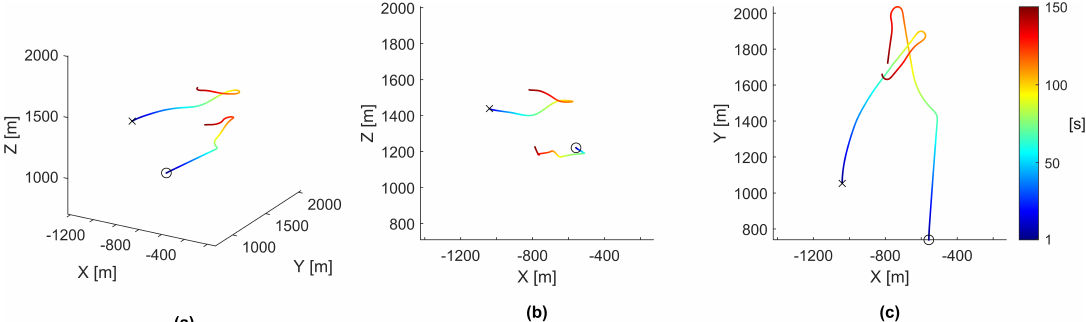
Figure 5. Paths of agents 19 and 30 as they work together to find and exploit a thermal updraft. Agent 19 is marked with an ‘x’ and agent 30 is marked with an ‘o’. Each individual agent’s path was colored by time from start to finish measured in seconds, as shown by the color-bar on the right side. The rendered path data only covers the first 150 s of the simulation. All panels show different perspectives of the same data. ( a ) The paths rendered from an upper-corner perspective. ( b ) The paths rendered from a side perspective. ( c ) The paths rendered from a top-down perspective.